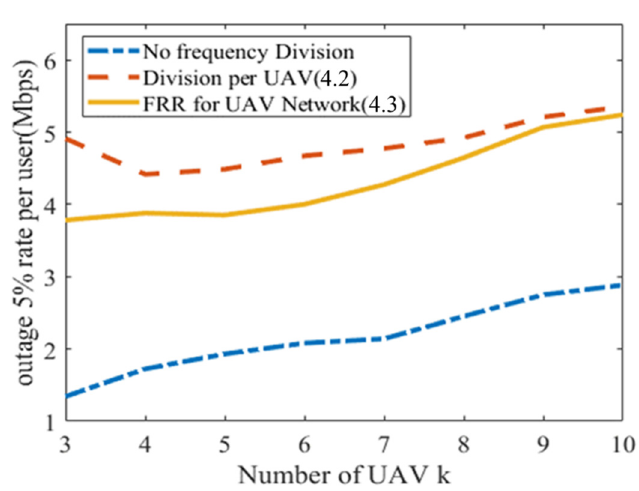
Figure 10. Outage 5% data rate for each number of UAVs.